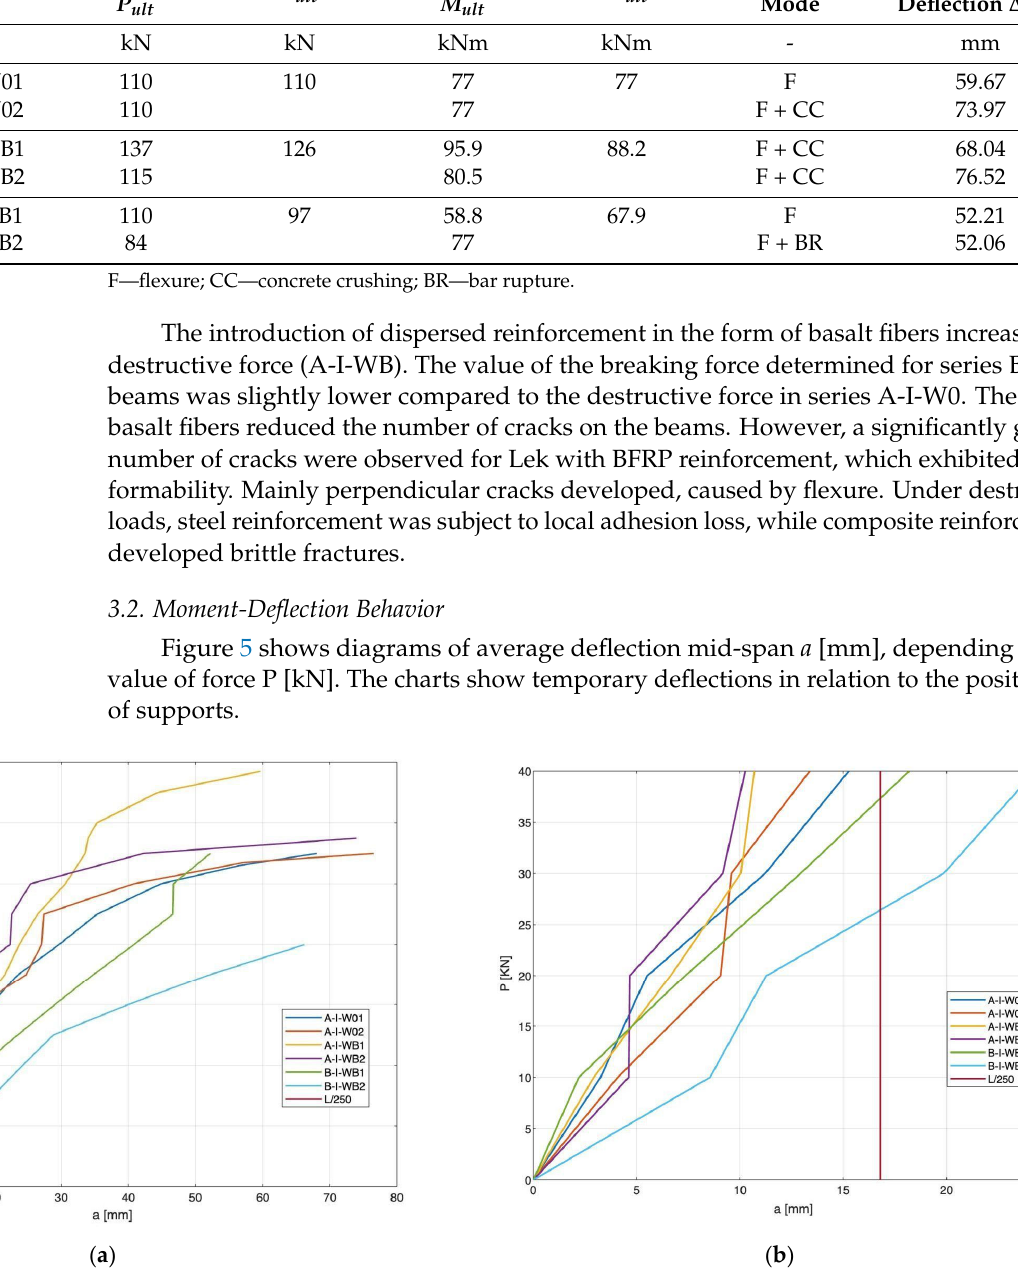
Table 4. Results of tests of beams.